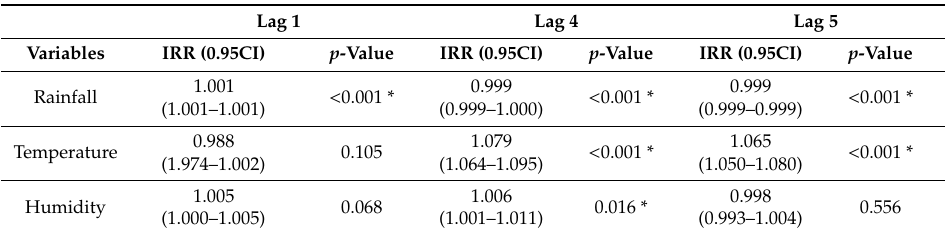
Figure 3. A Cross-correlation coefficient of malaria incidence and weather variables at different time lags (months). Table 2. The influence of weather variables on malaria incidence with lagged-months in Abuja (2000–2013).